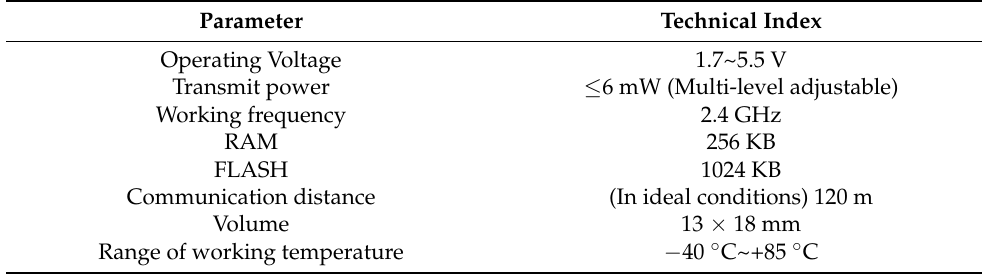
Table 2. E73-2G4M08S1C Bluetooth module performance